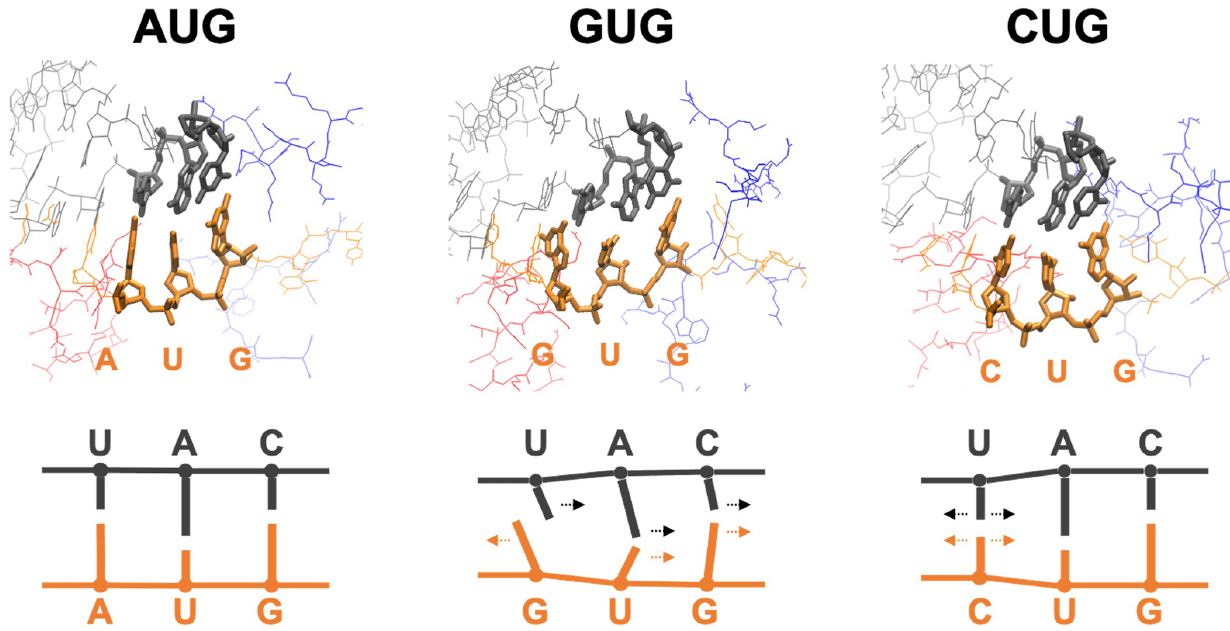
Fig 7. Typical bound structures. Averaged structures corresponding to reaction coordinate ð ~ d top, nucleotides of the codon (orange) and anticodon (gray) are drawn by thick lines. Red and blue lines are parts of eIF1 and eIF1A, respectively. Note that the structures of GUG and CUG pairing (middle and right) are much less stable than that of AUG pairing (left) (see Fig 4). The schematics on the bottom describe the direction of each base relative to the paired base.